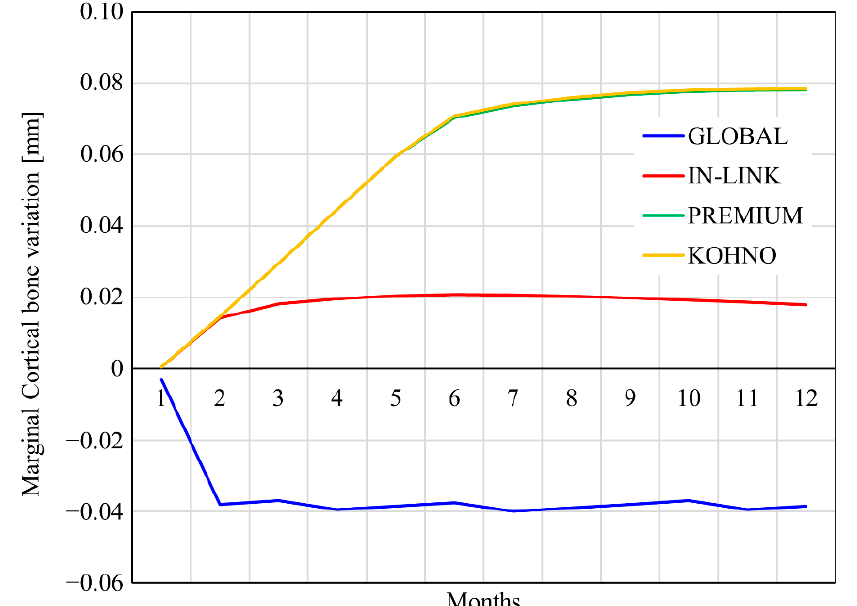
Figure 5. Marginal cortical bone evolution.